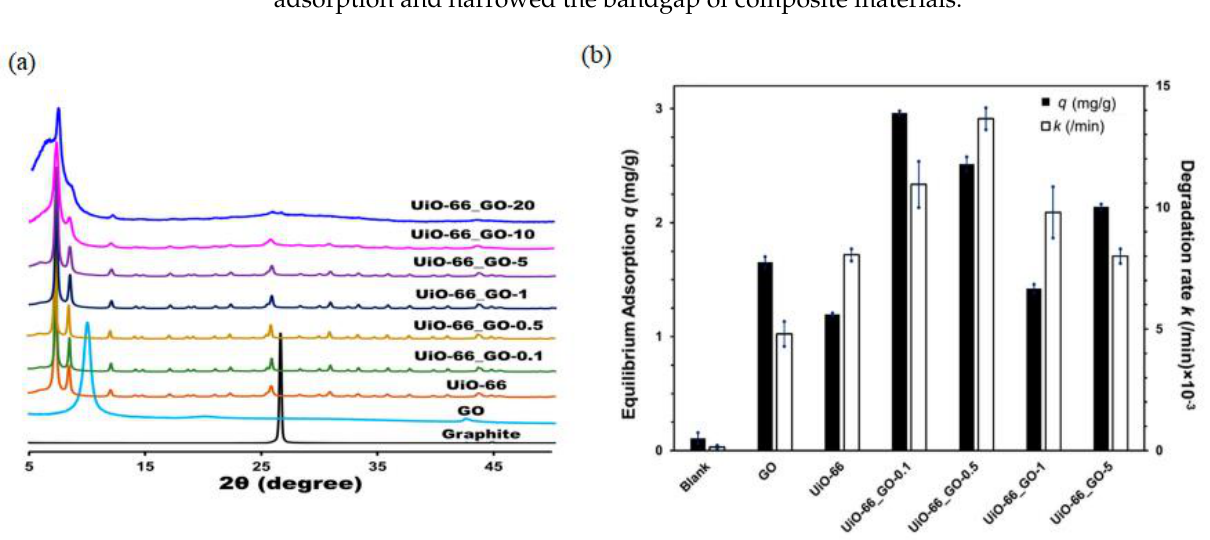
Figure 9. ( a ) XRD patterns of UiO-66/GO composites and ( b ) adsorption capacity and photocatalytic rate (k) of GO, UiO-66, and UiO-66/GO composites. Reproduced with permission from [61]. Copyright 2020, MDPI .